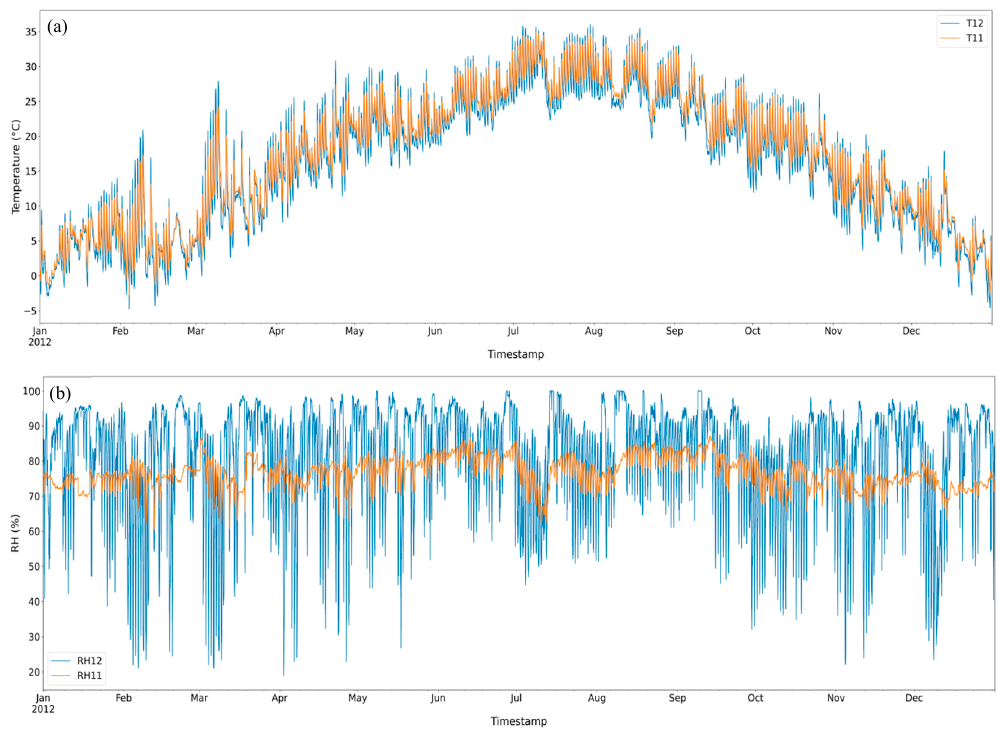
Figure 3. Temperature and relative humidity throughout the year: ( a ) T11 and T12; ( b ) RH11 and RH12.